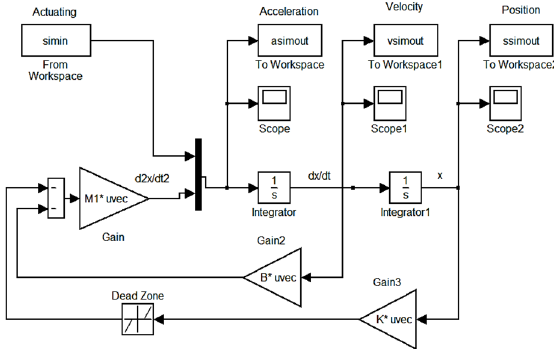
Figure 5. Schematic of the differential equation solver in Matlab R2022a -Simulink software, Math- Works, Natick, Massachusetts, USA, Humusoft s.r.o. (distributor for the Czech Republic).